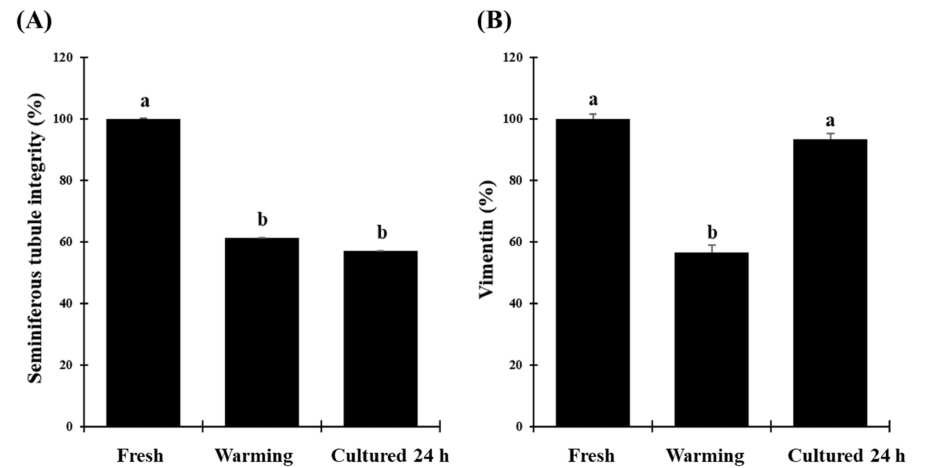
Figure 3. Morphological evaluation of fresh, vitrified / warmed (warming), or vitrified / warmed / cultured (cultured 24 h) testicular tissue from black-footed ferrets. ( A ) Proportion of intact seminiferous tubules, ( B ) proportion of Sertoli cells stained with vimentin. Data are expressed as mean ± SE ( n = 5 animals per treatment). Di ff erent letters above bars indicate significant statistical di ff erences between treatments ( p < 0.05).